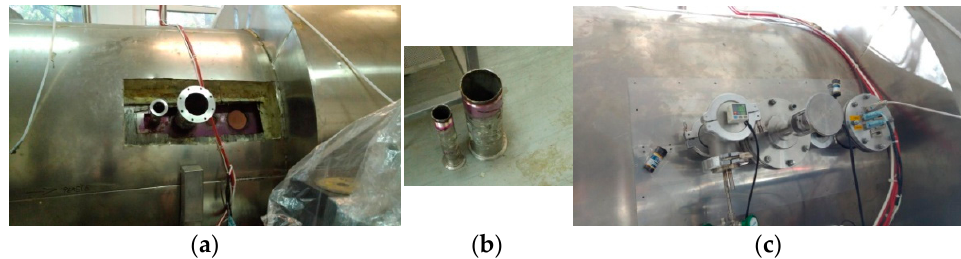
Figure 4. The tightness improvement of the radon chamber (the four lateral pipes processing): ( a ) cutting the external enclosure of the radon chamber and extraction of the lateral pipes; ( b ) two lateral pipes dismantled; ( c ) the final setup of the lateral pipes (after improvement).